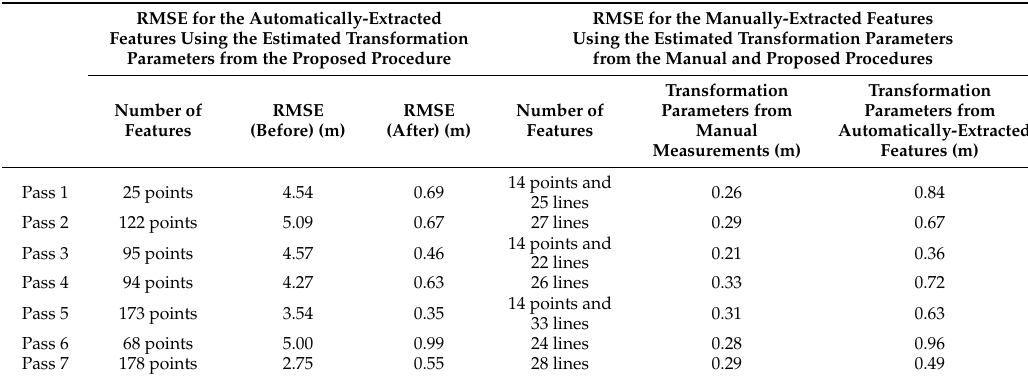
Table 3. Accuracy assessment of the quality of fit between the RGB-based and hyperspectral data before and after the geometric refinement for the acquired hyperspectral data on 4 August 2015. RMSE for the Automatically-Extracted RMSE for the Manually-Extracted Features Features Using the Estimated Transformation Using the Estimated Transformation Parameters Parameters from the Proposed Procedure from the Manual and Proposed Procedures